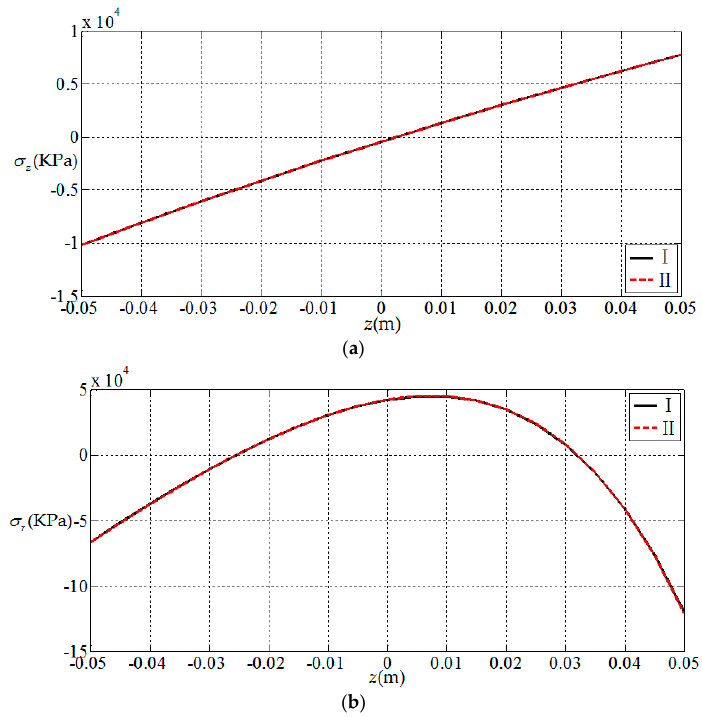
Figure 3. Variation of elastic stress with coordinates z , where I denotes the solution presented in this study; II denotes the solution presented in [32]. ( a ) z -direction stress at the periphery of plate σ z ( 1, z ) ; ( b ) radial stress at the periphery of plate σ r ( 1, z ) . Materials 2018 , 11 , x FOR PEER REVIEW